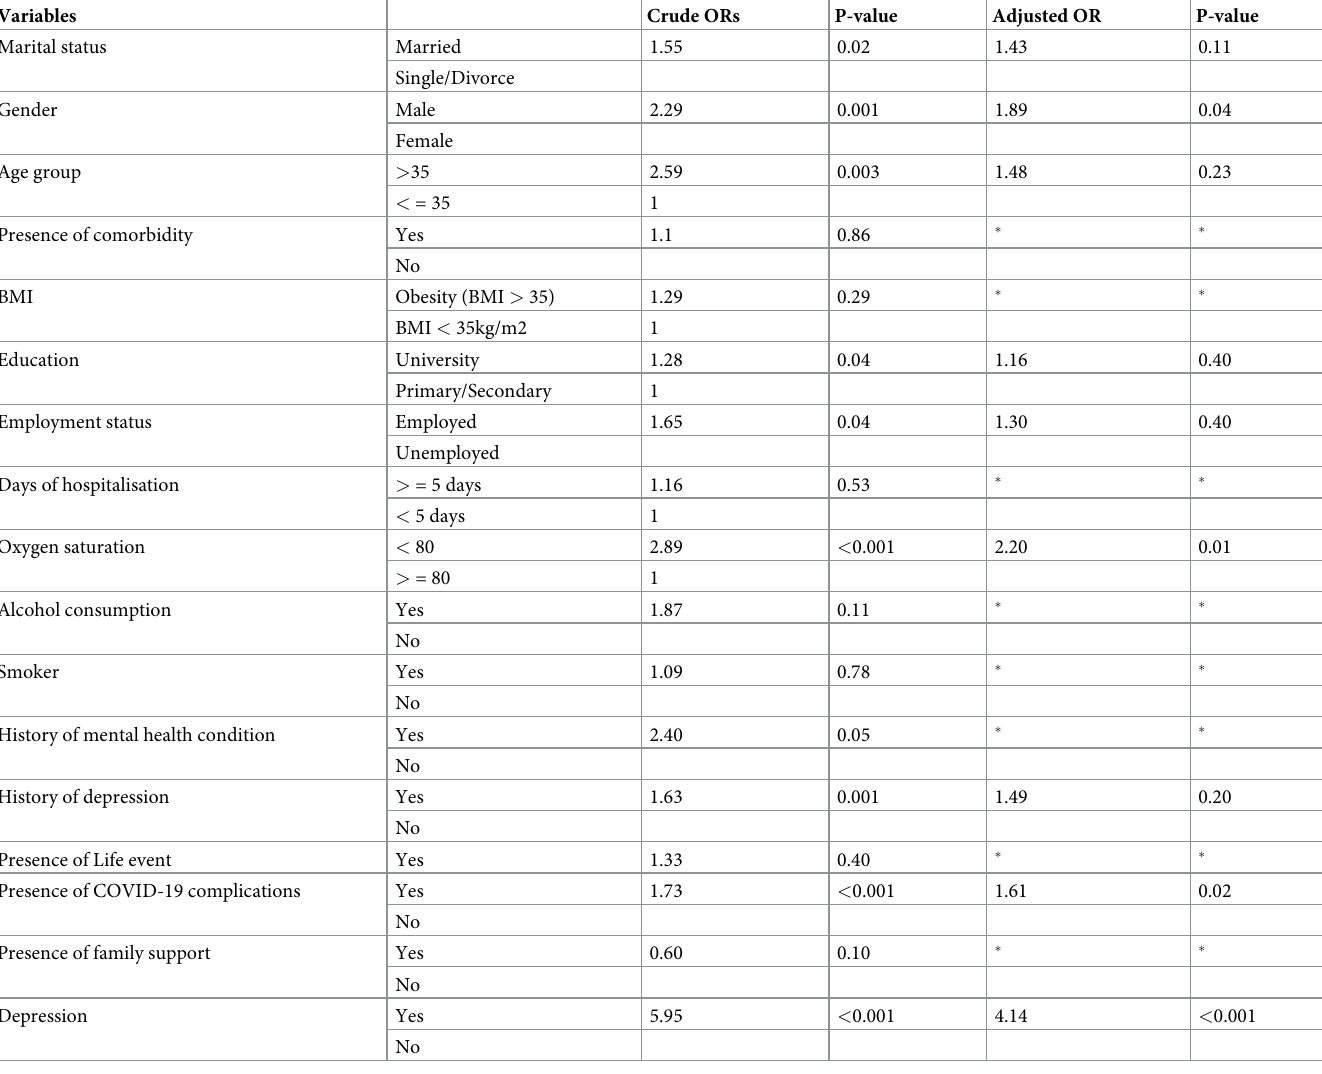
Table 3. Factors associated with